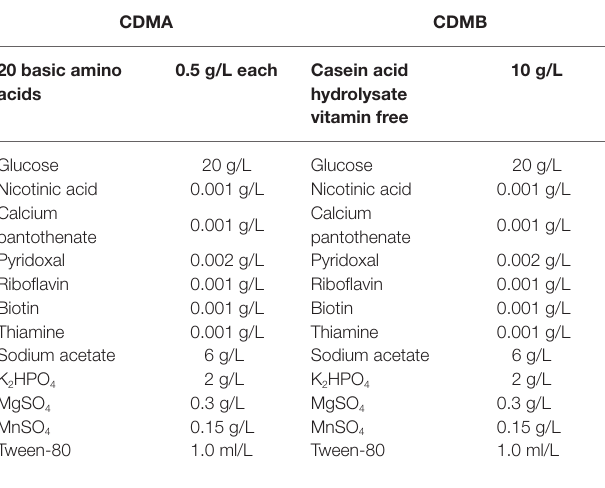
TABLE 1 | The two chemically defined mediums of CDMA and